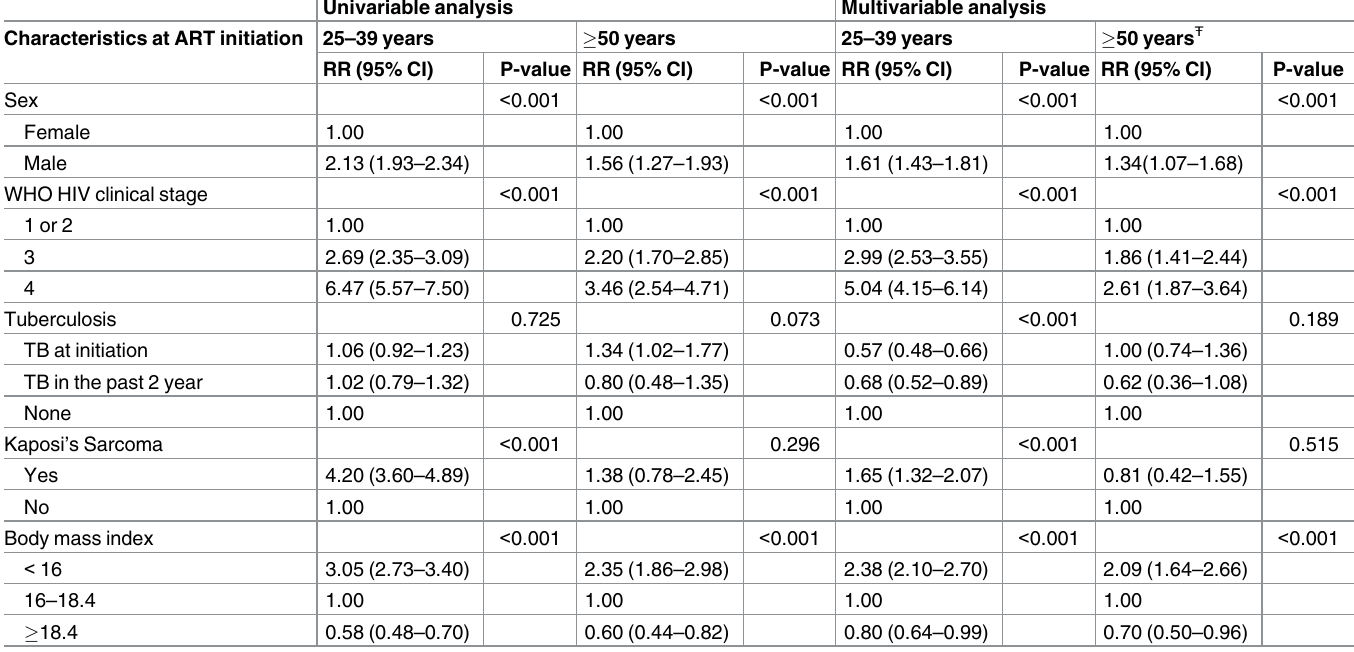
Table 3. Univariable and multivariable model of characteristics associated with mortality among adult ART patients aged 25–49 yearsand those aged (cid:21) 50